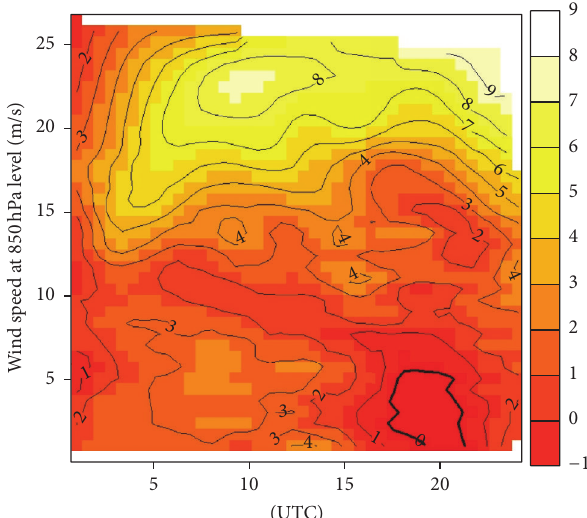
Figure 2: Mean divergence at the surface over the Antarctic Peninsula as a function of time of the day and the 850-hPa mean wind speed.